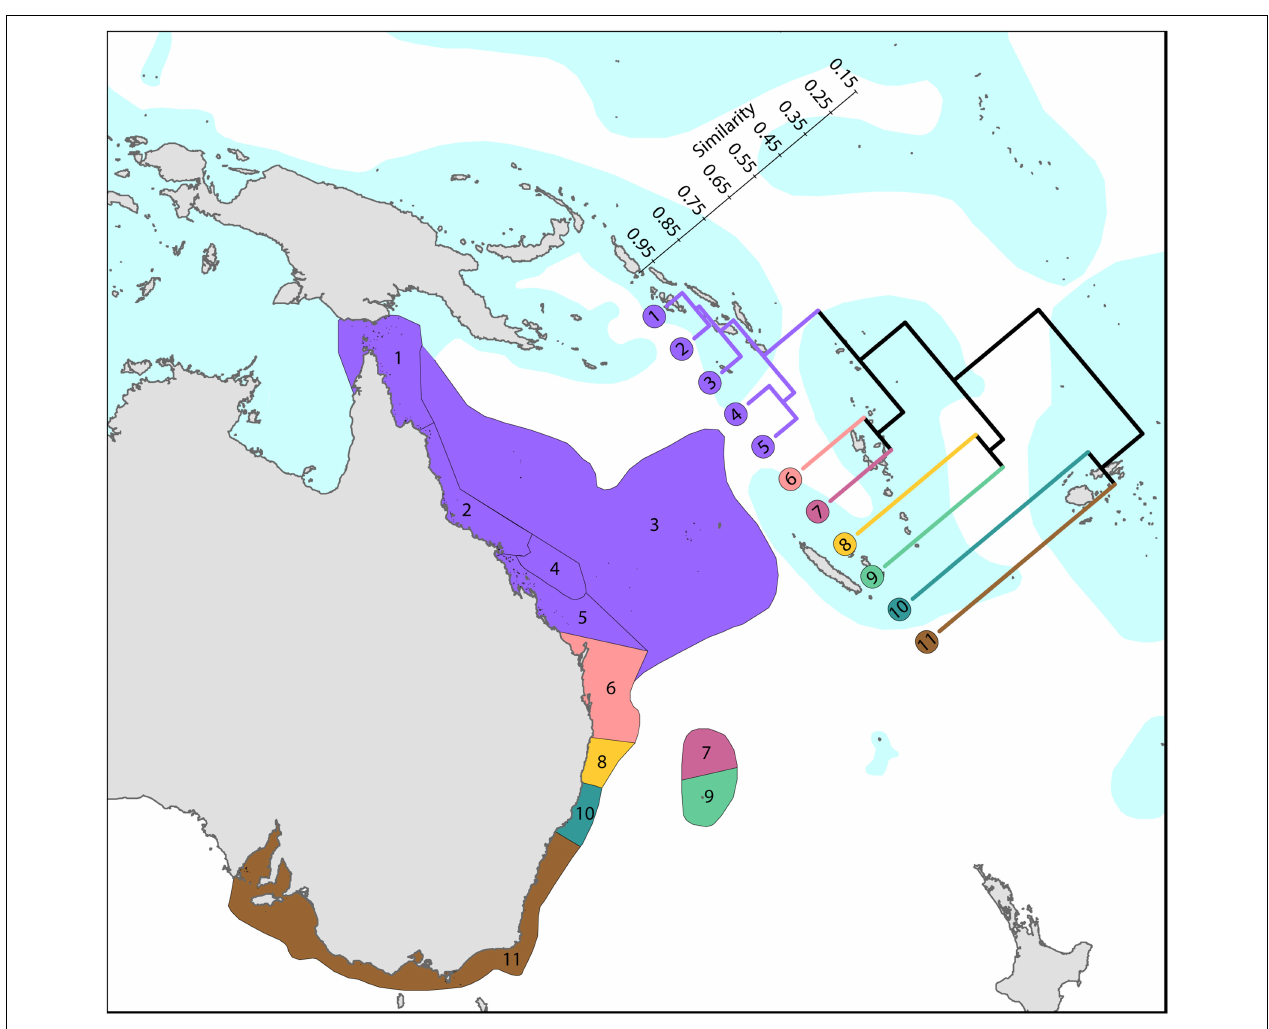
FIGURE 10 | Latitudinal attenuation of affinity and diversity of ecoregions along the path of, or under the influence of, the East Australian Current. The two southern coastal ecoregions (numbered 10 and 11) are depauperate outliers whilst the Solitary Islands (numbered 8) groups